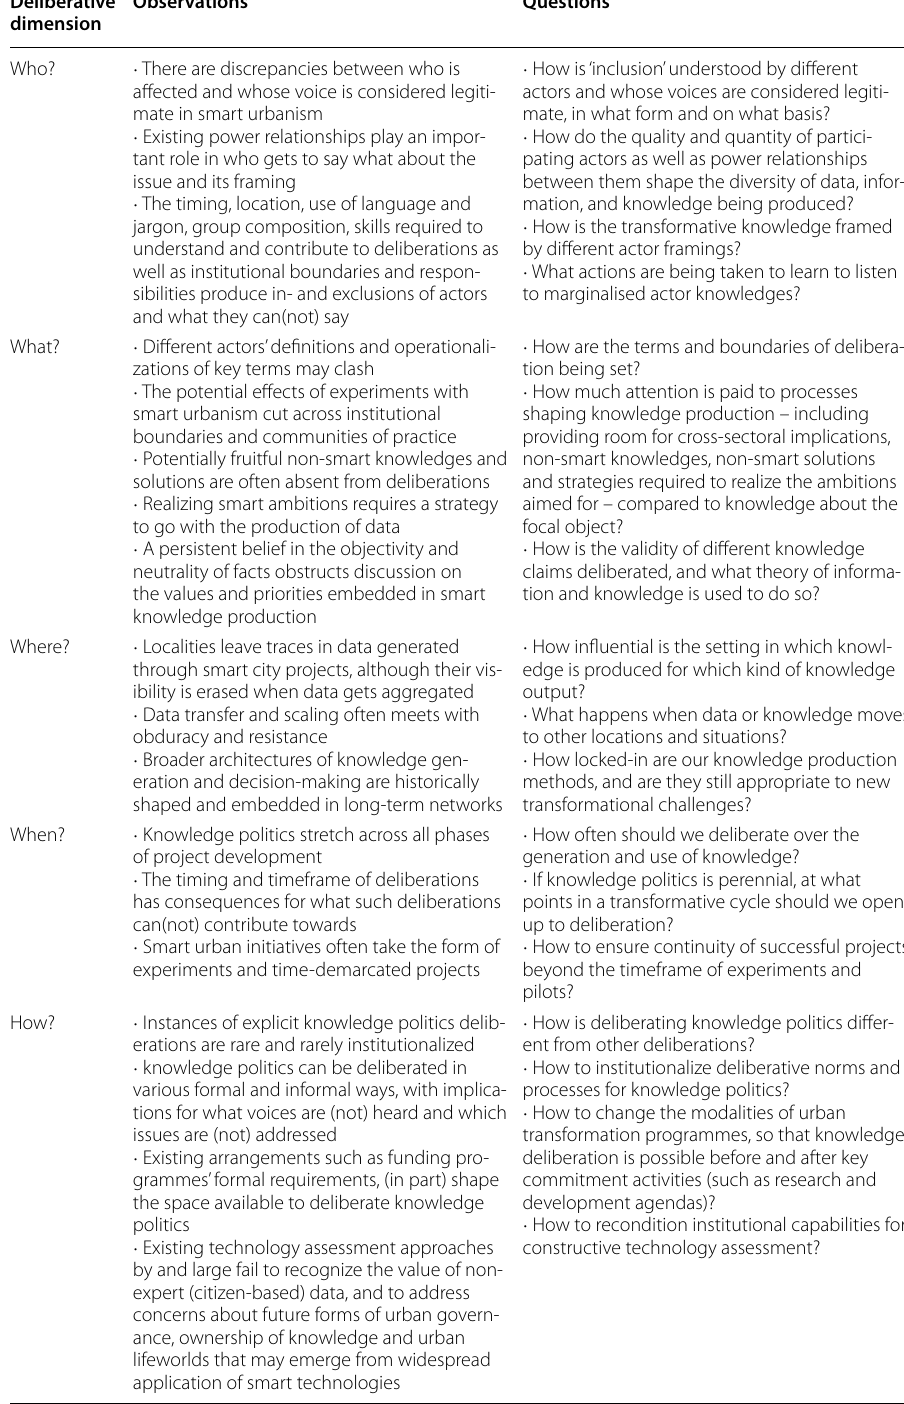
Table 1 Observations and questions regarding deliberative spaces for knowledge politics in urban transformations Deliberative